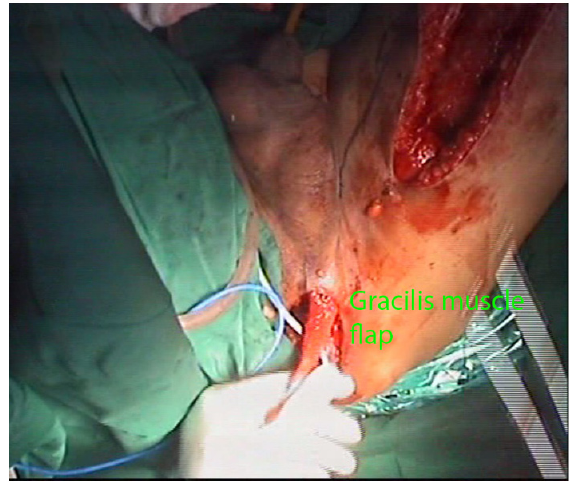
Figure 6. Gracilis muscle flap rotated to